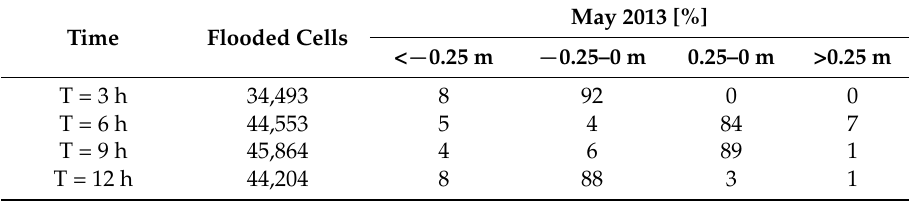
Table 7. Percentage of cells inundated at the convective event in May